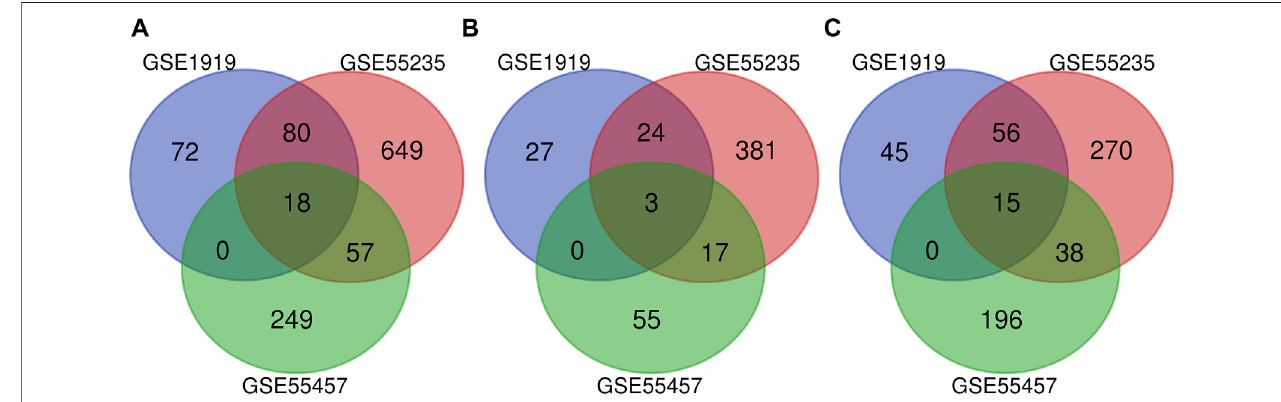
FIGURE 4 | Venn diagram indicating the intersection genes among three datasets. (A) All DEGs, (B) upregulated DEGs, and (C) downregulated